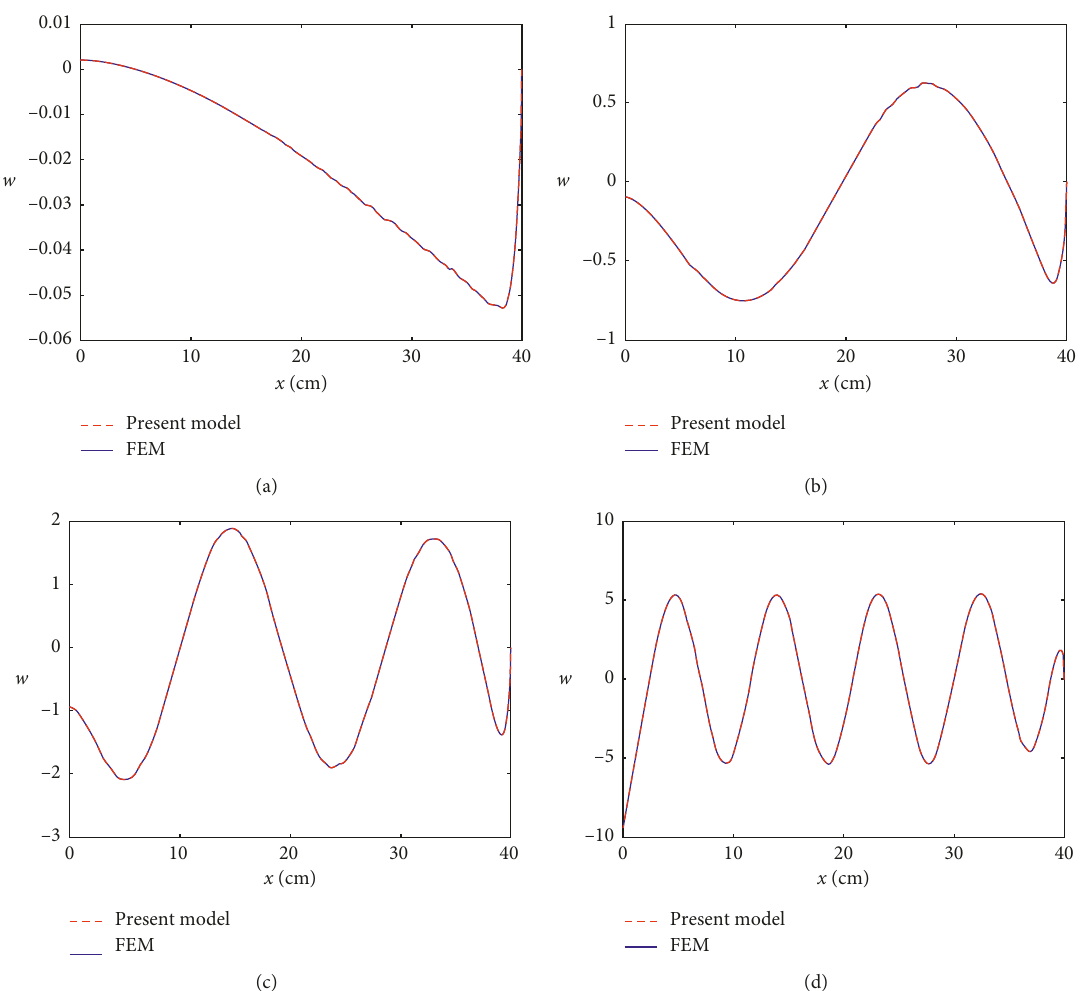
Figure 4: Modal shapes of the bare ABH beam calculated with the present model and FEM method: (a) first mode; (b) sixth mode; (c) twelfth mode; (d) twenty-ninth mode.